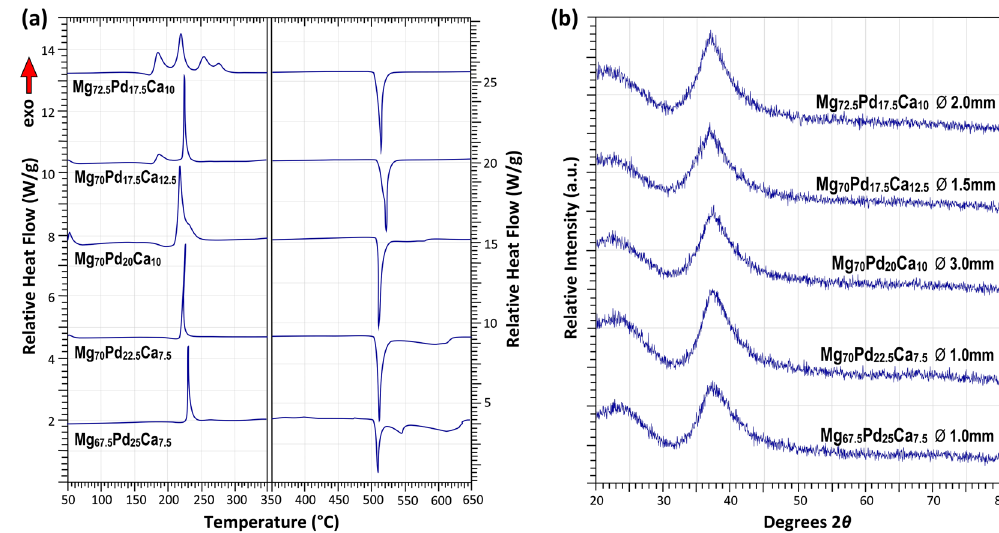
Figure 4. Selected ( a ) DSC and ( b ) XRD traces of Mg–Pd–Ca